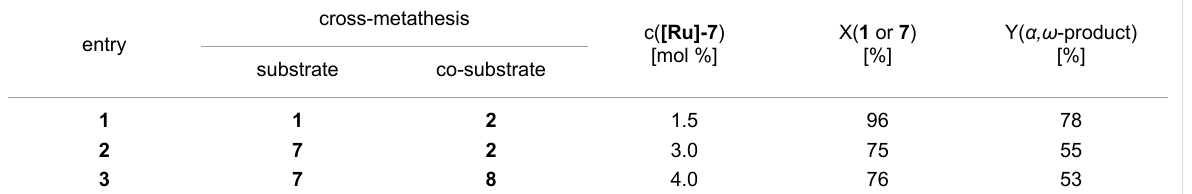
Table 6: Influence of the protecting groups on the ruthenium catalysed cross-metathesis. a